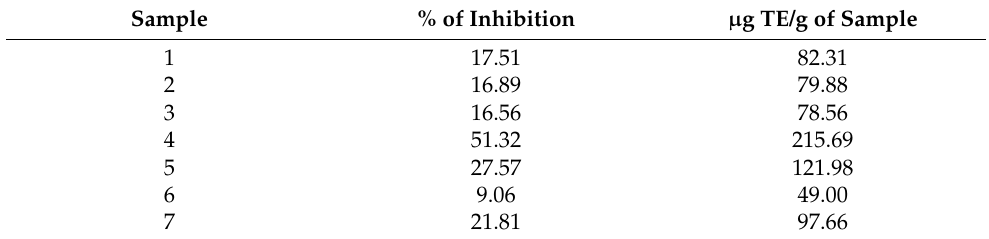
Table 3. Results expressed as percentage of inhibition and in µ g Trolox equivalent (TE)/g of sample (DPPH